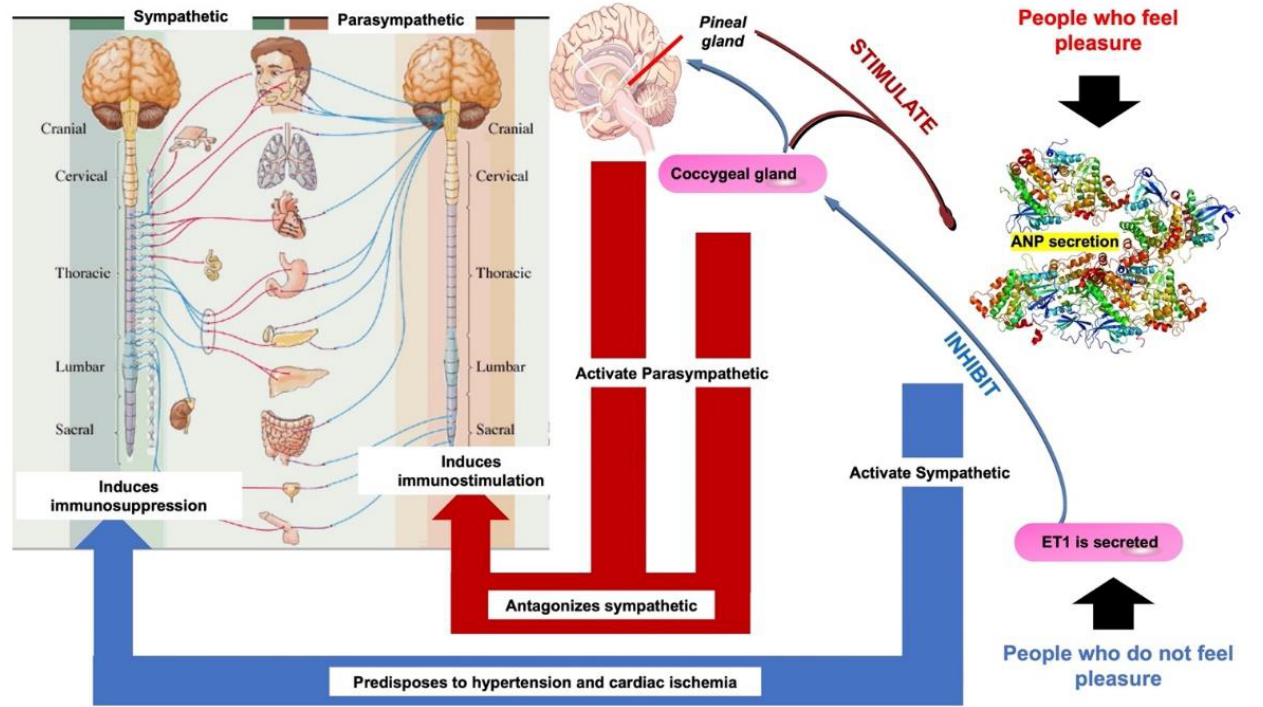
Figure 4. The effect of pleasure on the sympathetic and parasympathetic response induces immunosuppression or immunostimulation, respectively. ED Torres-Sánchez modified this image, obtained from the Creative Commons BY base of an unknown author.